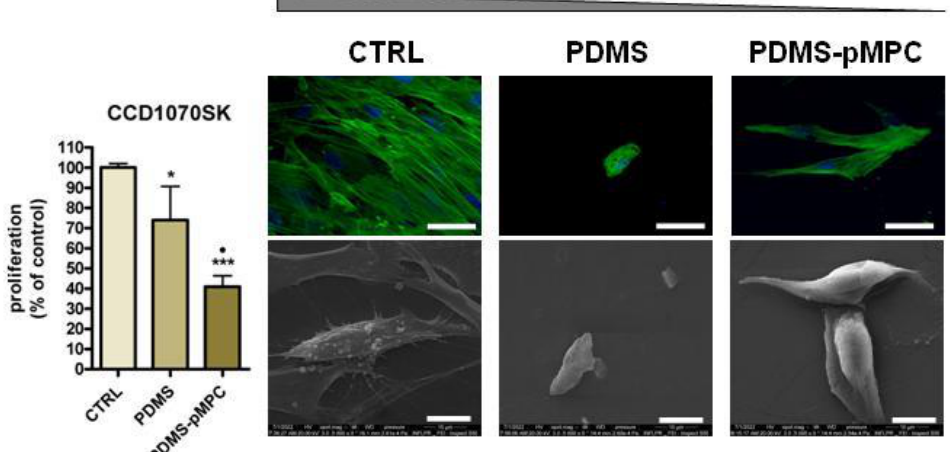
Figure 11. Proliferation, morphology and adhesion of CCD-1070Sk fibroblasts on PDMS scaffolds (with or without MPC). Cells cultured on glass coverslip served as control (CTRL). MTS data are shown as mean ± standard deviation values of triplicates in each group. *** p < 0.001, * p < 0.05 vs. CTRL, • p < 0.05 vs. PDMS surface. Representative fluorescence microscopy images of cells cultured on all surfaces (objective 40×). Cells were labelled for actin (green) and nuclei (blue). Scale bar 50 µm. Representative SEM microscopy images of fibroblasts’ morphology on surface materials at 5000× magnification (Inspect S Electron Scanning Microscope). Scale bar 10 µm.